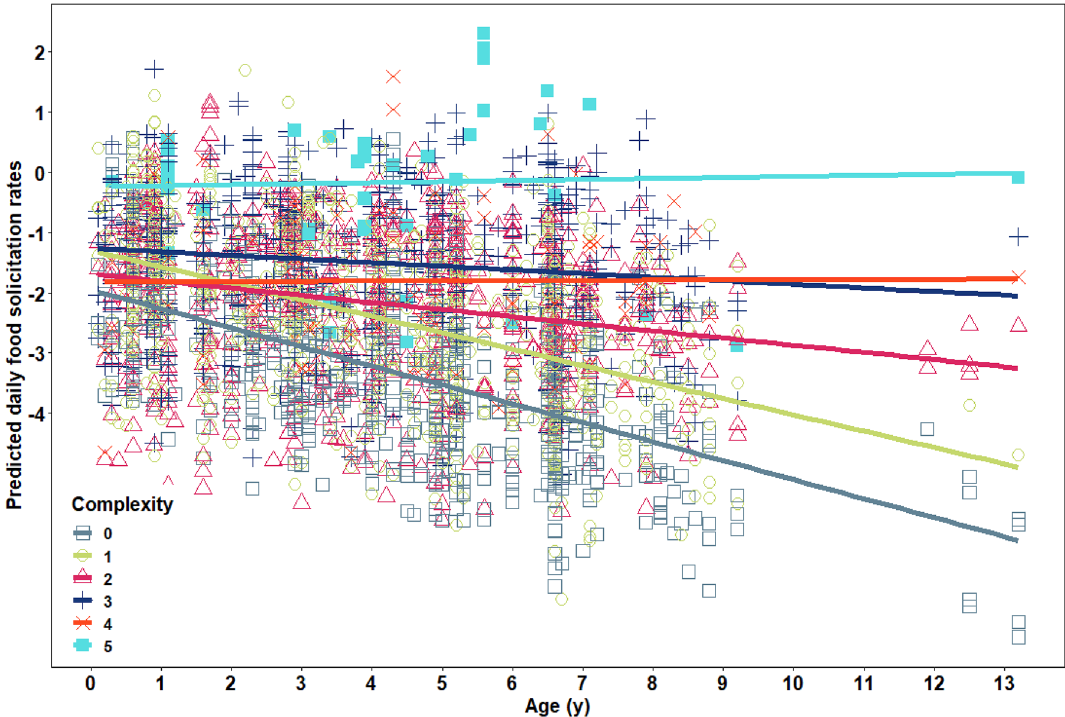
Figure 2. Effects of the offspring’s age (in years) and the complexity of the food item on predicted food solicitation rates. Complexity was assessed via the number of manual and oral steps it took to process a food item before ingestion and ranged from 0 to 5. The food solicitation opportunities (i.e., the number of feeding bouts of the mother) were log transformed. The lines show the fitted probability at the 95% level (model 2 , dataset 2 , N = 3071 food solicitation rates).